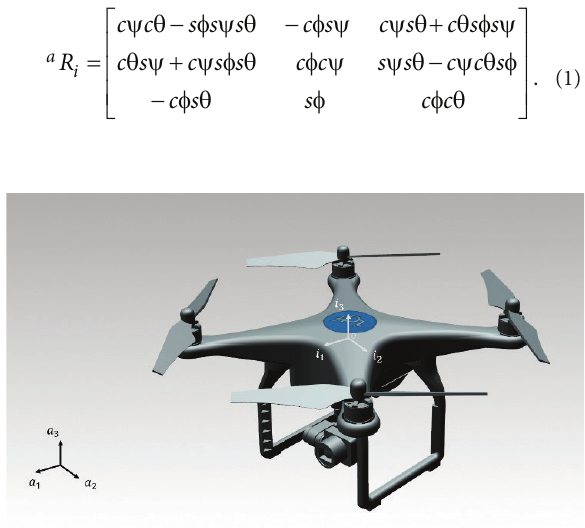
Figure 2. Damaged leading edge of a wind turbine blade (Motion, 2017)